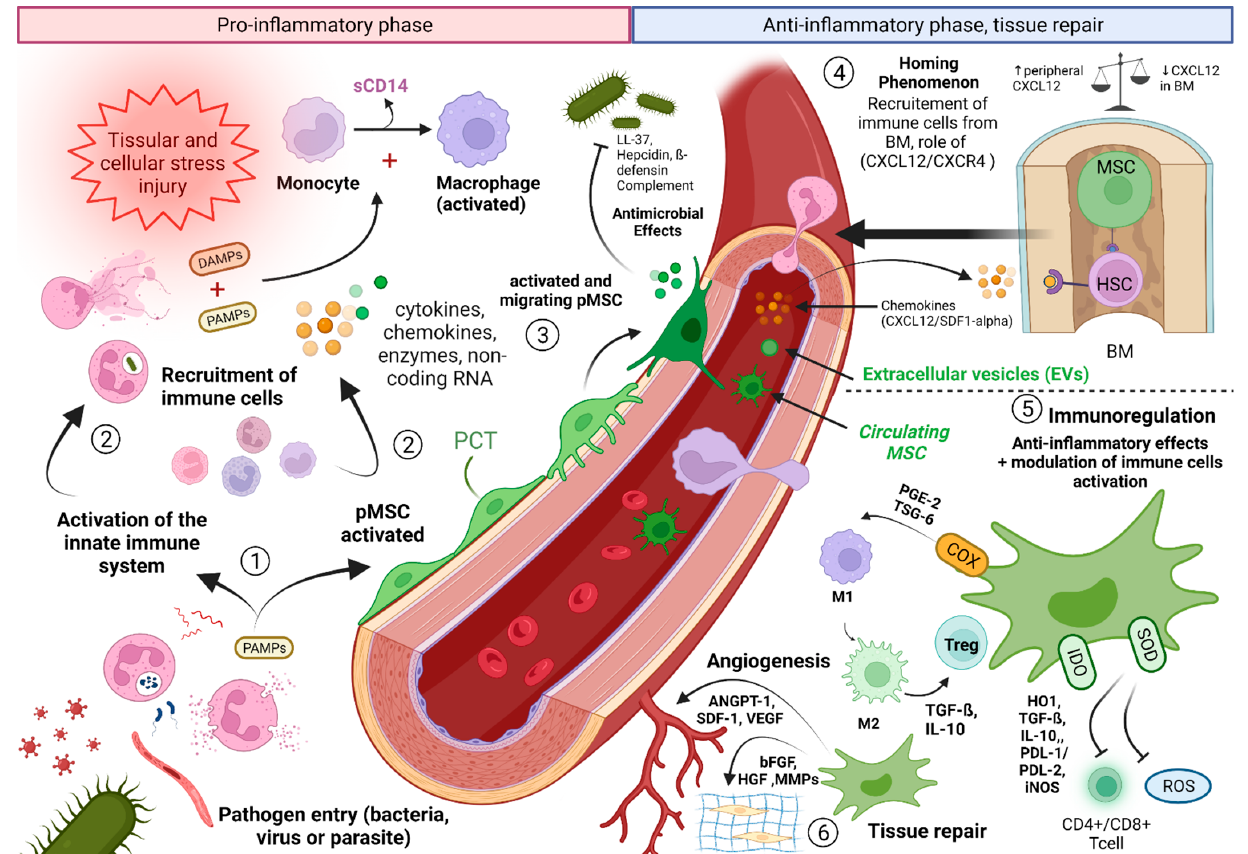
Figure 4. Illustration of the crosstalks between MSCs and cells of the innate and acquired immune systems during the development and the resolution of septic shock in the host. 1 (cid:13) The inflammatory response and activation of the innate immune system at the site of the initial injury allow differentiation and activation of resident immune cells (e.g., macrophages) as well as perivascular MSCs (pMSC), both expressing a myriad of pattern recognition receptors for pathogens (PAMPs)